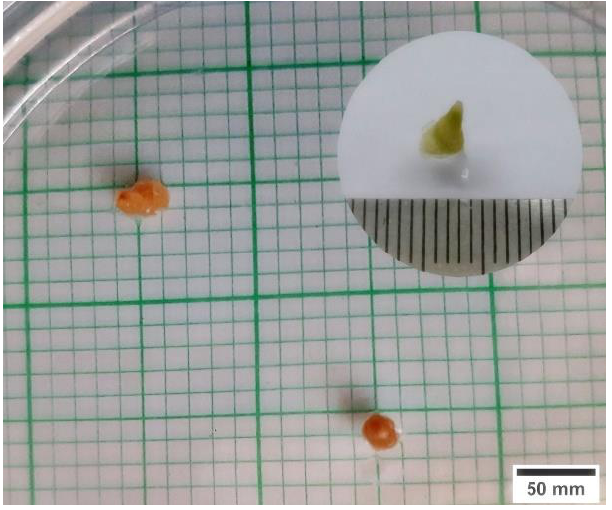
Figure 5. Visual observation of a viable axillary bud of L. discolor exhibiting a green colour (insert) compared with completely brown cryopreserved axillary buds obtained from a melatonin-treated culture after 3 weeks.